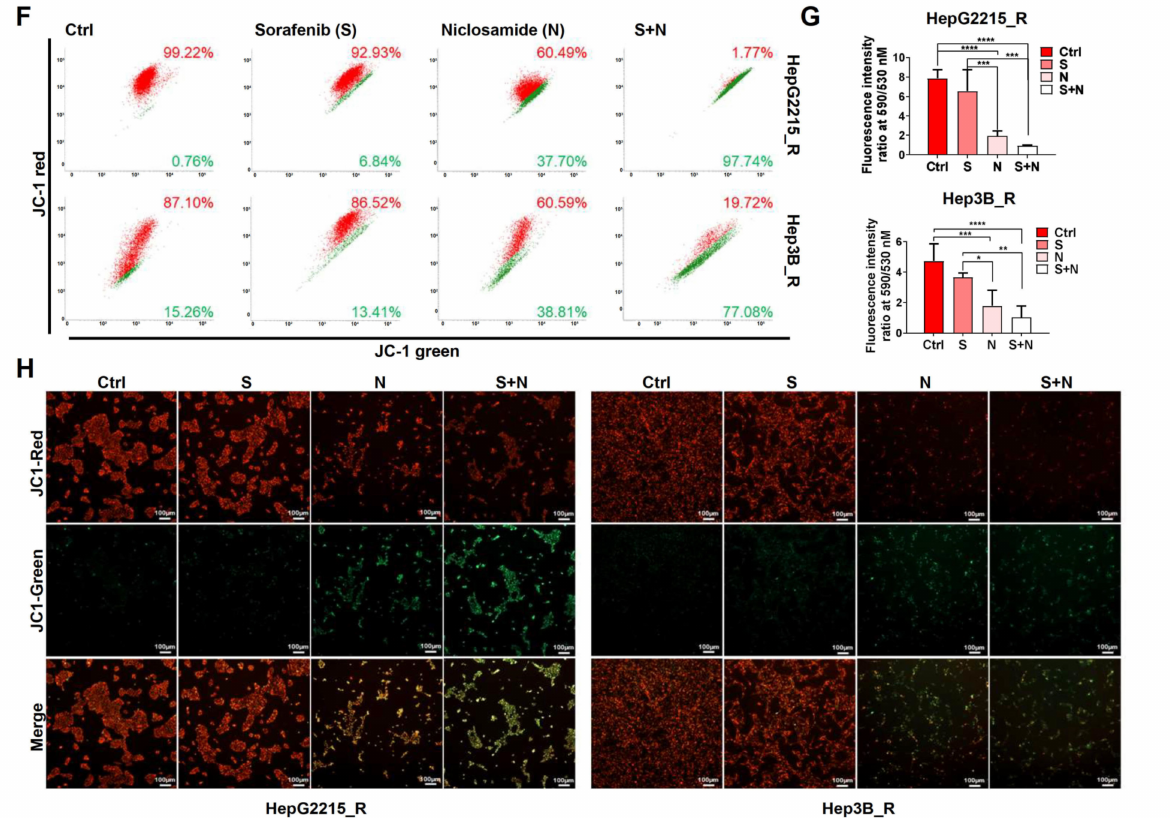
Figure 4. Niclosamide enhanced the ability of sorafenib by decreasing glycolysis and mitochondrial membrane potential in sorafenib-resistant HCC cells. ( A ) Schematic of glucose metabolism in normal cells and cancer cells under normoxia. ( B ) Representative enzymes in glycolysis and oxidative phosphorylation. Glut, glucose transporter; HK2, hexokinase 2; LDH, lactic dehydrogenase; PEPPCK, phosphoenolpyruvate carboxykinase. ( C ) Gene expression levels of glycolysis-related enzymes in both sorafenib-naïve and sorafenib-resistant HCC cells ( D ) or their organoids ( E ) under different experimental conditions for 24 h were shown. Control group (Ctrl), sorafenib alone (S, 10 µ M), niclosamide alone (N, 3 µ M), and niclosamide plus sorafenib (S + N). Real-time RT-qPCR analyses. ( F ) JC-1 staining levels of sorafenib-resistant HCC cells (HepG2215_R and Hep3B_R) under different experimental conditions for 48 h. Control group (Ctrl), sorafenib alone (S, 10 µ M), niclosamide alone (N, 3 µ M), and niclosamide plus sorafenib (S + N). Flow cytometry dot plot analysis for the gating of JC1 (red)-aggregates and JC1 (green)-monomer populations. ( G ) Fluorescence intensity ratio at 590 nm/530 nm and ( H ) the cell images of ( F ). * p < 0.05, ** p < 0.01, *** p < 0.001, and **** p < 0.0001, as obtained from one-way